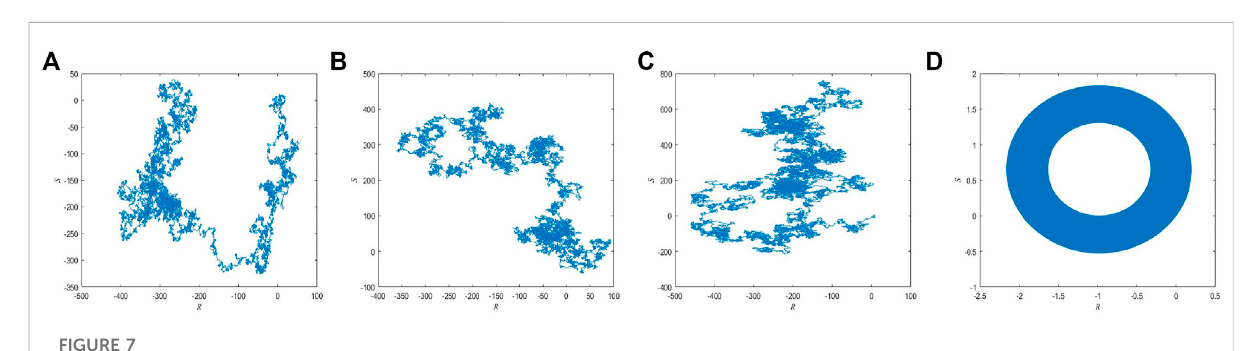
FIGURE 7 0 – 1 test. (A) φ = 2.3, γ = 3.9. (B) φ = 3, γ = 5.9. (C) φ = 5, γ = 7. (D) φ = 2.3 γ =